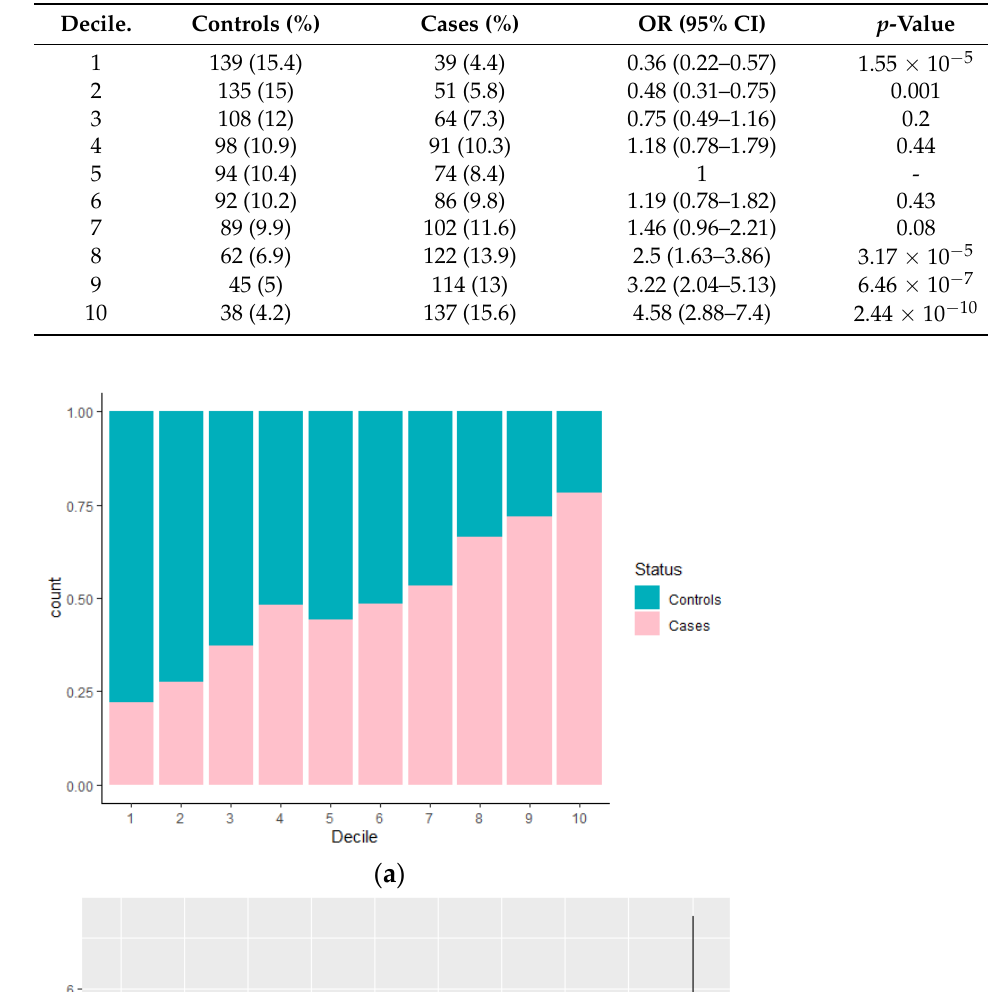
Table 2. Total number of controls and cases of the MASTOS study included in each decile, when the dataset was divided based on the predicted risk probability of the integrated risk model. The estimated ORs (95% CI) of each decile for breast cancer risk were generated from logistic regression using the 5th decile as the reference.